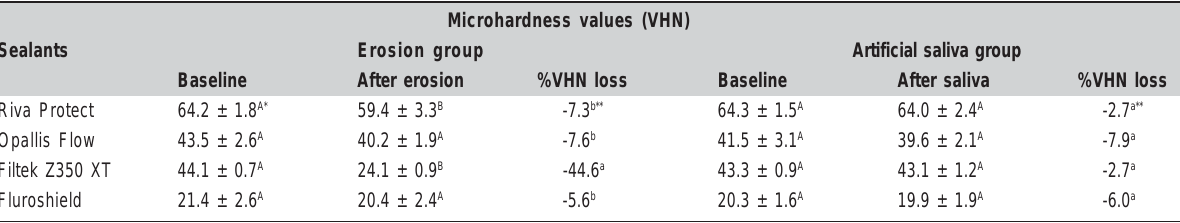
Table 3 - Surface microhardness (VHN) and percentage of VHN loss of sealant materials after erosive challenge and immersion in artificial saliva (control). Values expressed as means ± standard deviations